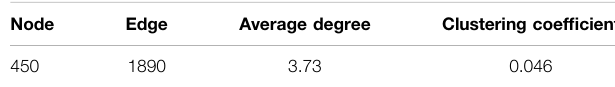
Frontiers in Physics |